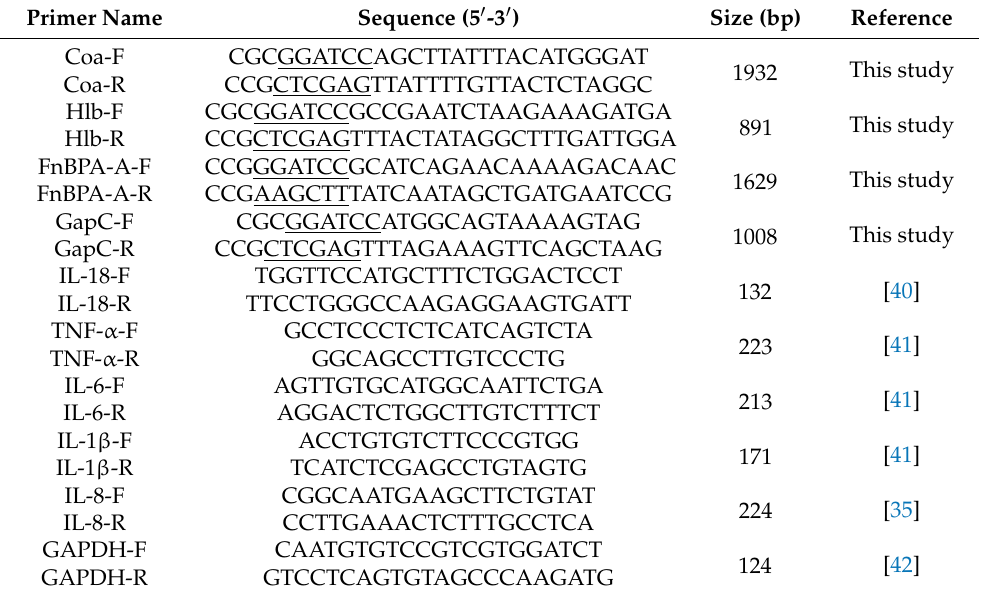
Table 1. List of primers used in this